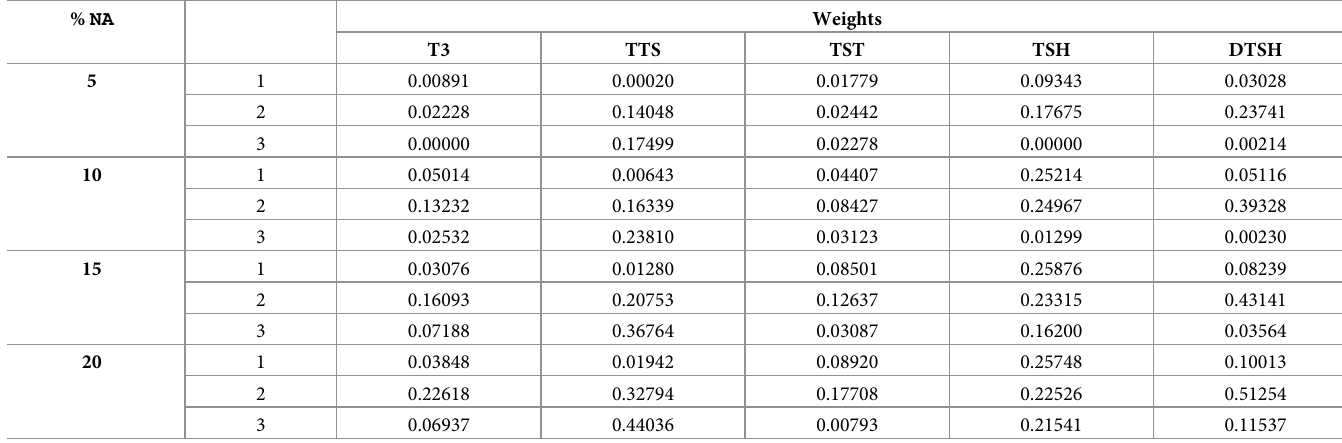
Table 15. Consistency of variables in the VKFCM-K-LP clustering with the imputation of missing values using mean values for the Thyroid Gland